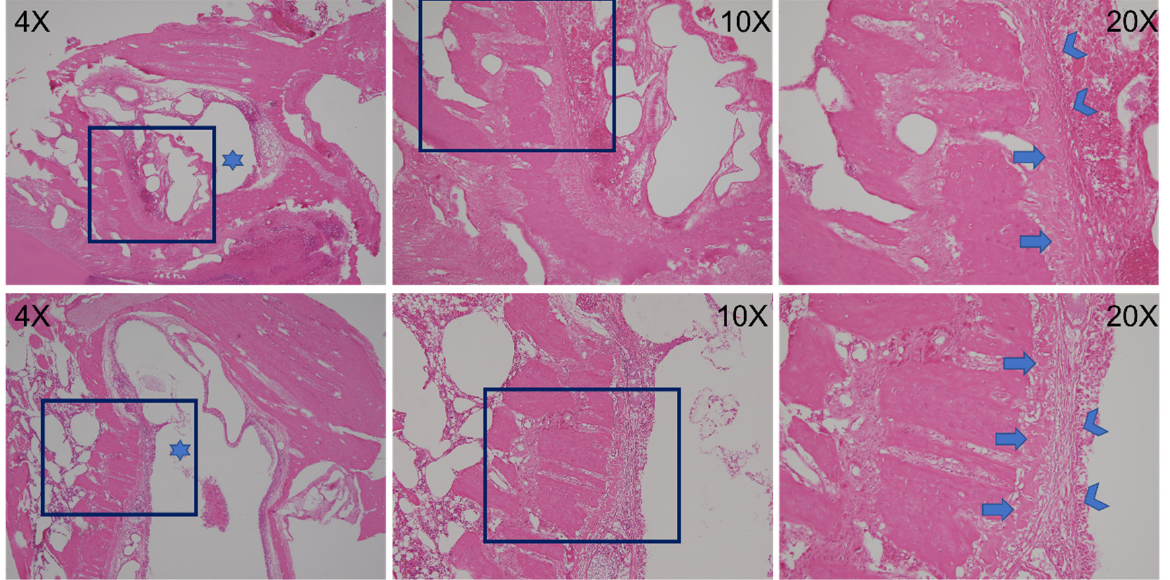
Figure 14. Postoperative day 7 ( upper row ) and day 14 ( lower row ) histology. At the lowest degree of magnification (left, 4× objective), surgically created bone defects were noted (stars). At the highest degree of magnification (right, 20× objective), the bone defects were rimmed by histiocytes (arrowheads, 20× objective). Noted around the bone defect was newly formed woven bone (arrows, 20× objective) that was thicker in the specimen taken on postoperative day 14 compared with that taken on postoperative day 7.